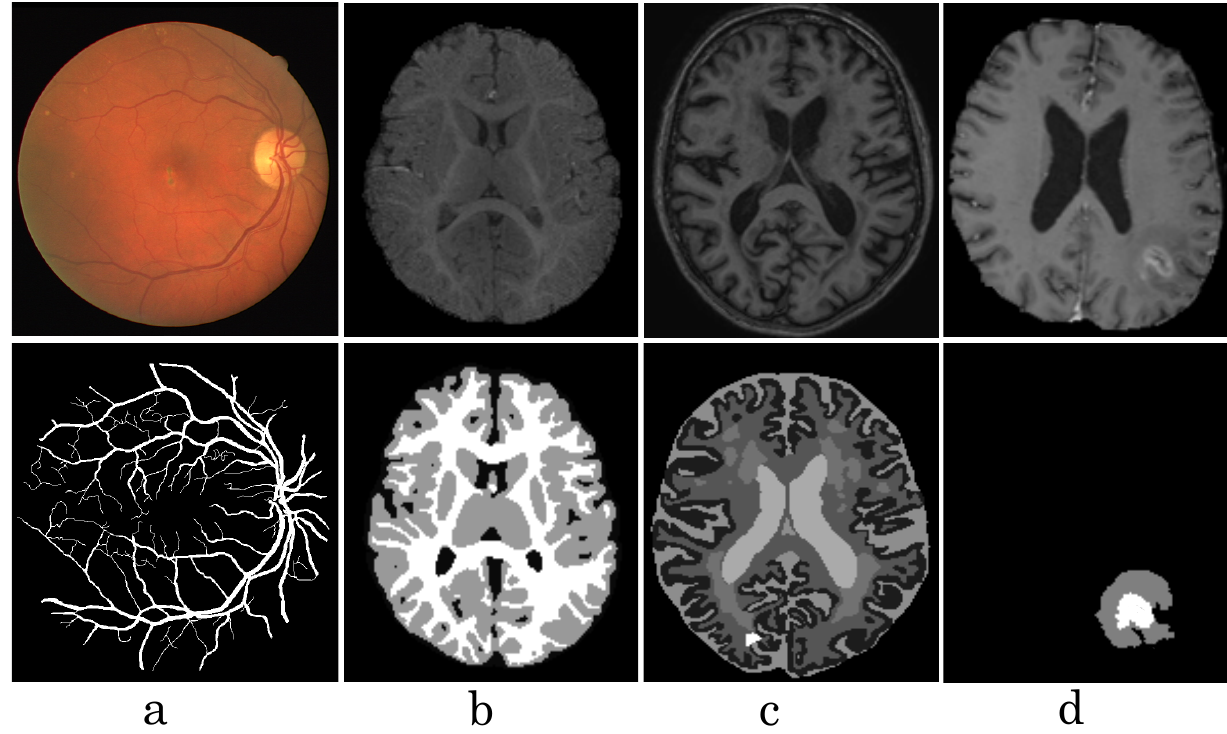
Figure 1. Visualization of some medical images from different datasets, such as DRIVE ( a ), iSeg17 ( b ), MRBrainS18 ( c ), Brats18 ( d ). The first row shows raw input images, the second row shows labeled